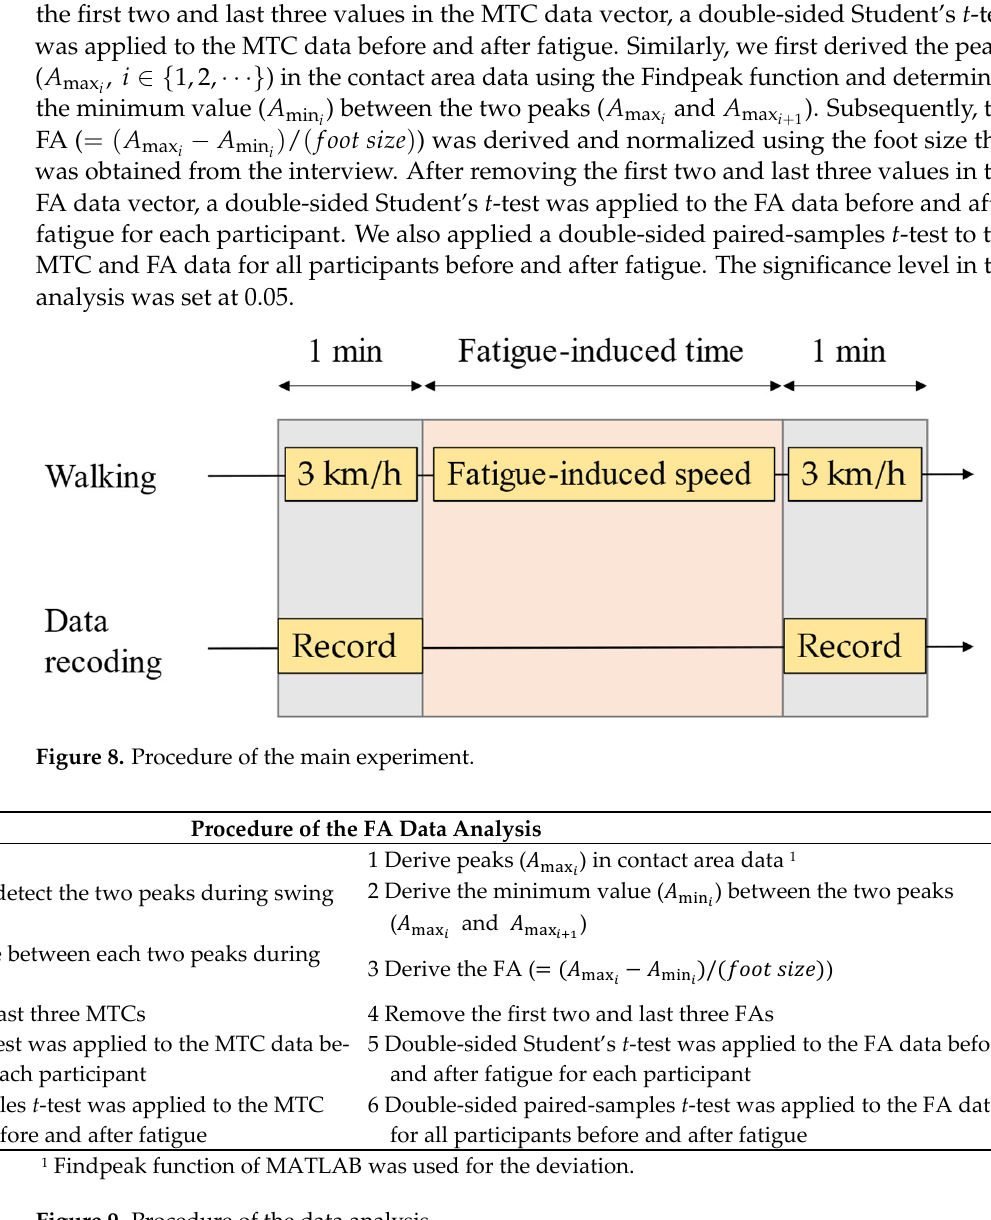
Figure 9. Procedure of the data analysis.